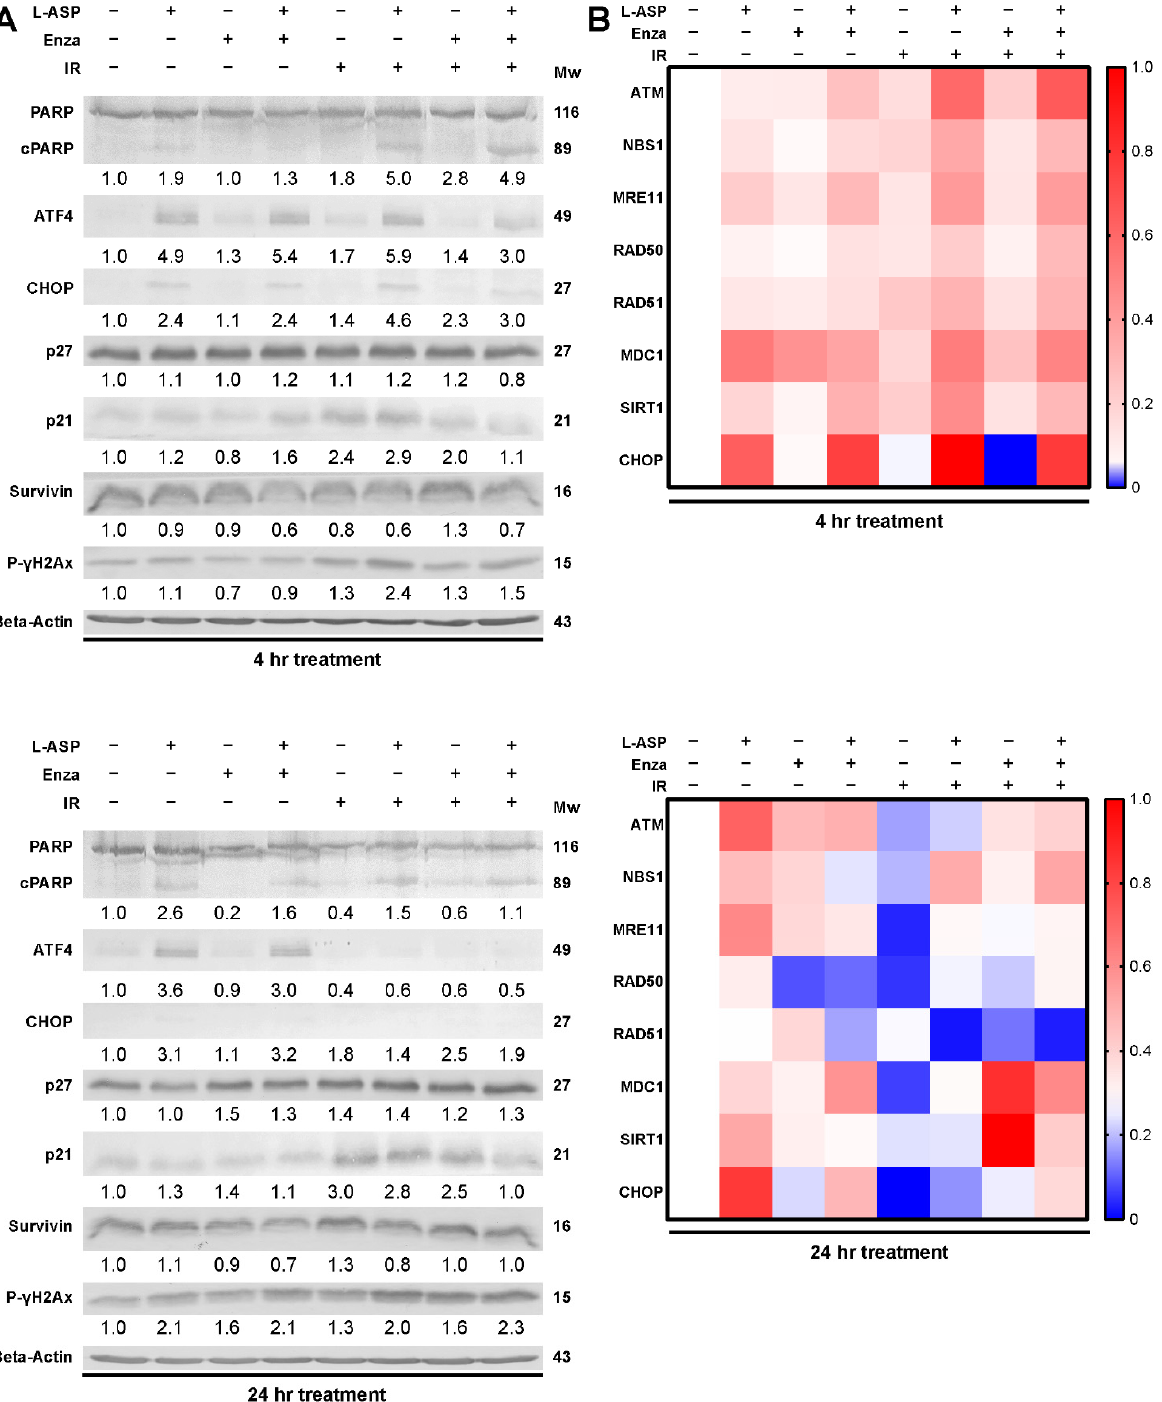
Figure 4. L-ASP potentiates IR effects by delaying DNA damage repair. 22RV1 cells were pre-treated with L-ASP (2 IU/mL), enzalutamide (10 µM), or both for 24 h. Cells were harvested at the indicated times after irradiation (0 or 4 Gy). ( A ) Western blots of 22RV1 cell lysates were probed for PARP, cleaved PARP, ATF4, CHOP, p27, p21, survivin, and p- γ -H2Ax. Representative blots are shown with the mean relative quantitation indicated normalized to ß-actin expression. Molecular weights (kDa) are indicated. ( B ) mRNA expression of DNA damage repair genes was measured by RT-PCR. Data are reported as a mean of three independent experiments.